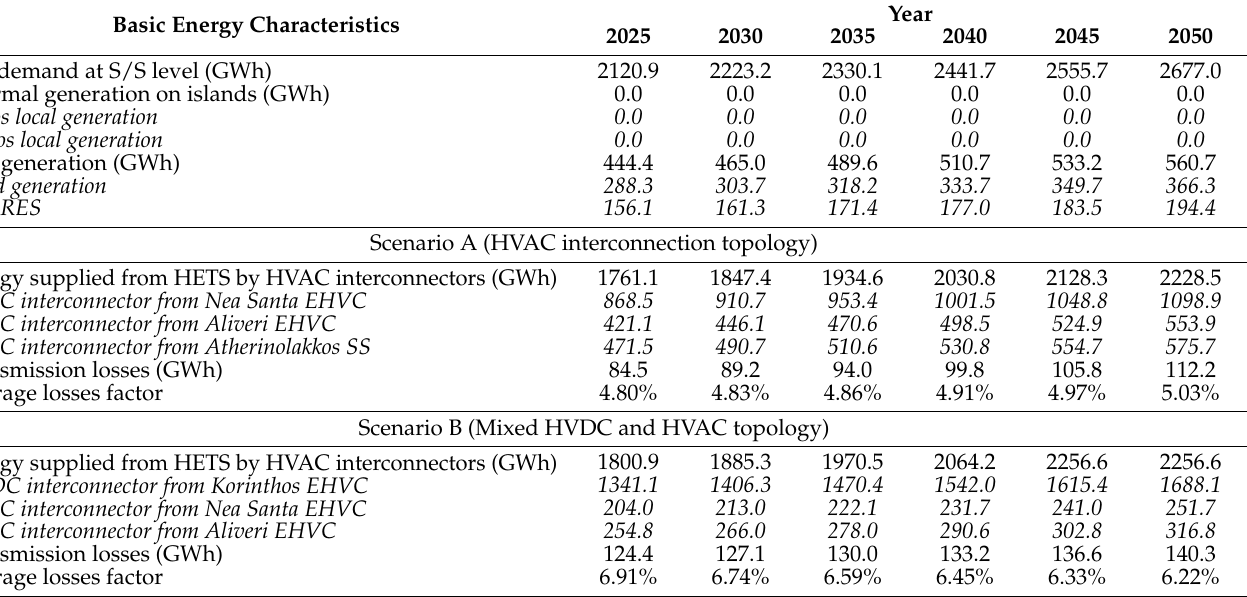
Table 4. Energy simulation